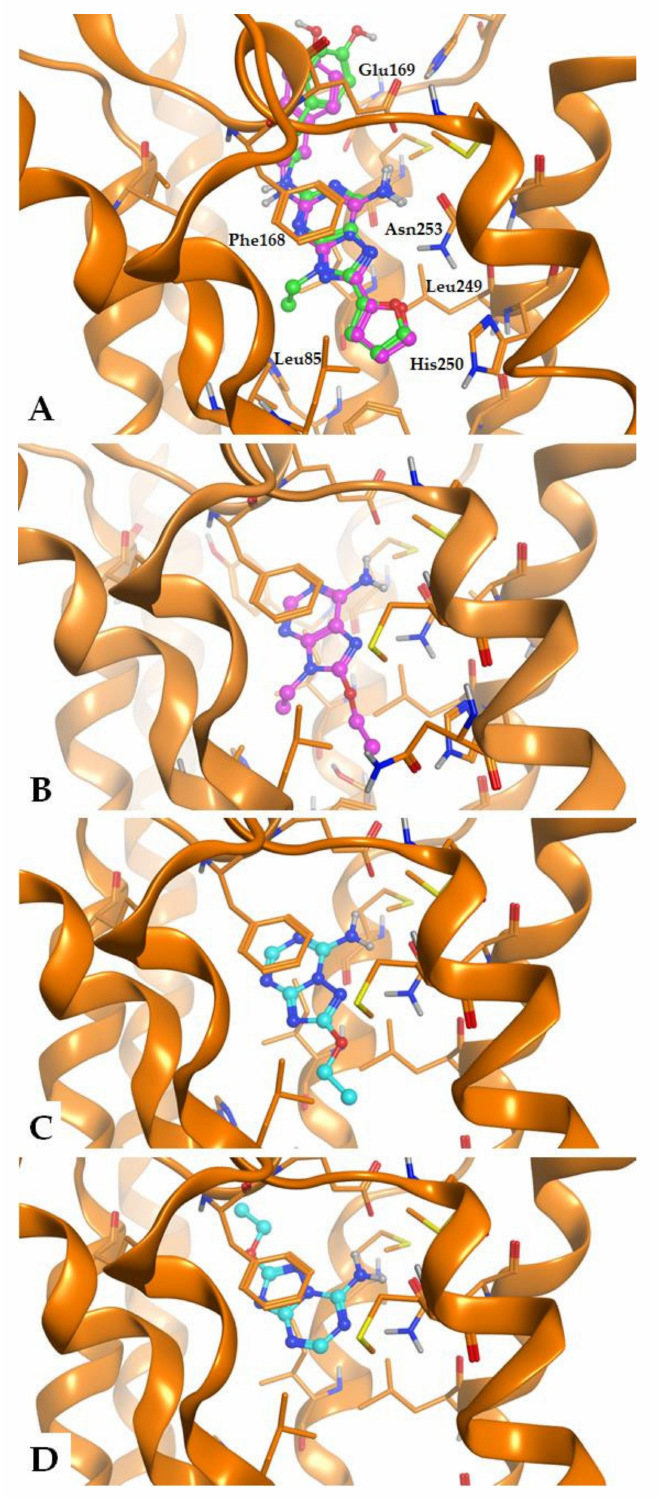
Figure 7. General binding mode of the synthesized compounds at the A 2A AR (pdb: 5NM4) binding cavity, with indication of some key receptor residues. ( A ) Compound 13 is shown in green, with the co-crystallized ligand ZM241385 (purple) for comparison; ( B ) Docking conformations of compound ANR 94 ( 5 , purple); ( C , D ) Docking conformations of compound 21 (cyan) with representation of the two observed potential binding